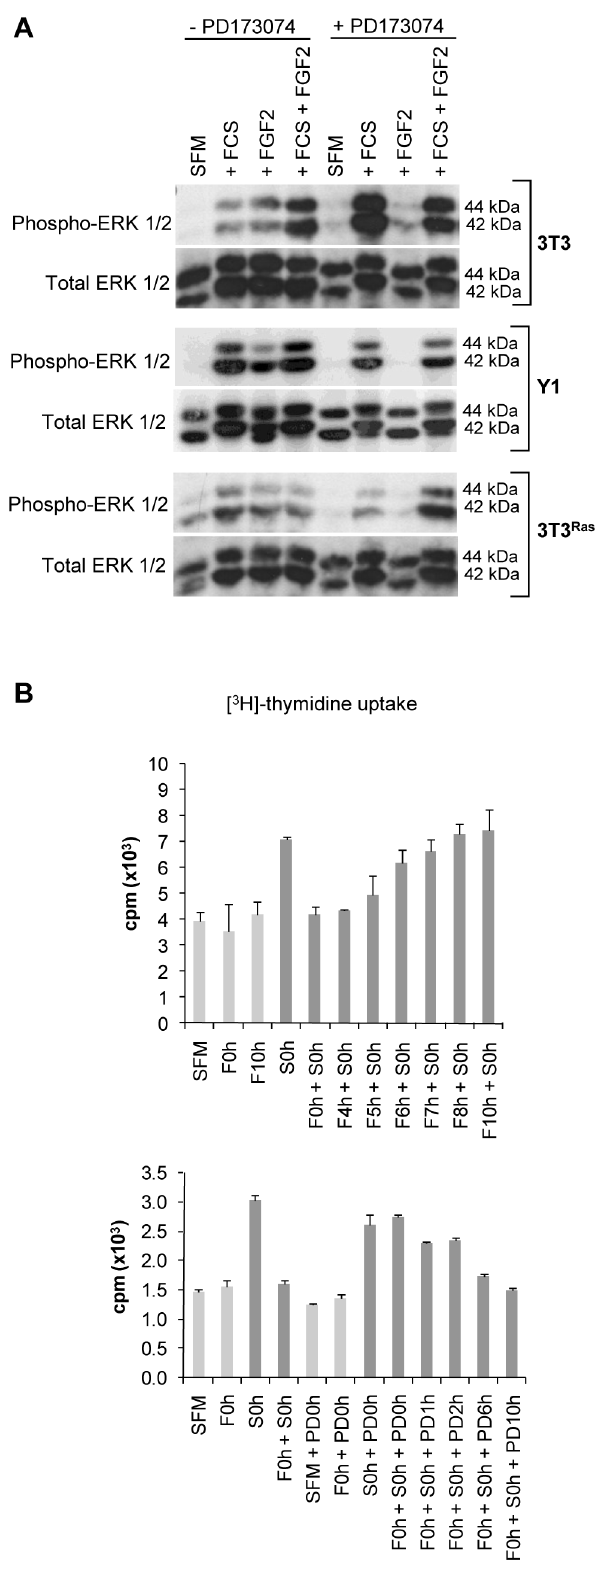
Figure 3. ( A ) FGF2 exerts its classical mitogenic activity via FGF receptor tyrosine kinase activation. Balb 3T3, Y1, and 3T3 Ras cells were synchronized in G0/G1 by serum starvation and stimulated with FCS (10%) and/or FGF2 (10 ng/mL) for 5–15 minutes in the presence